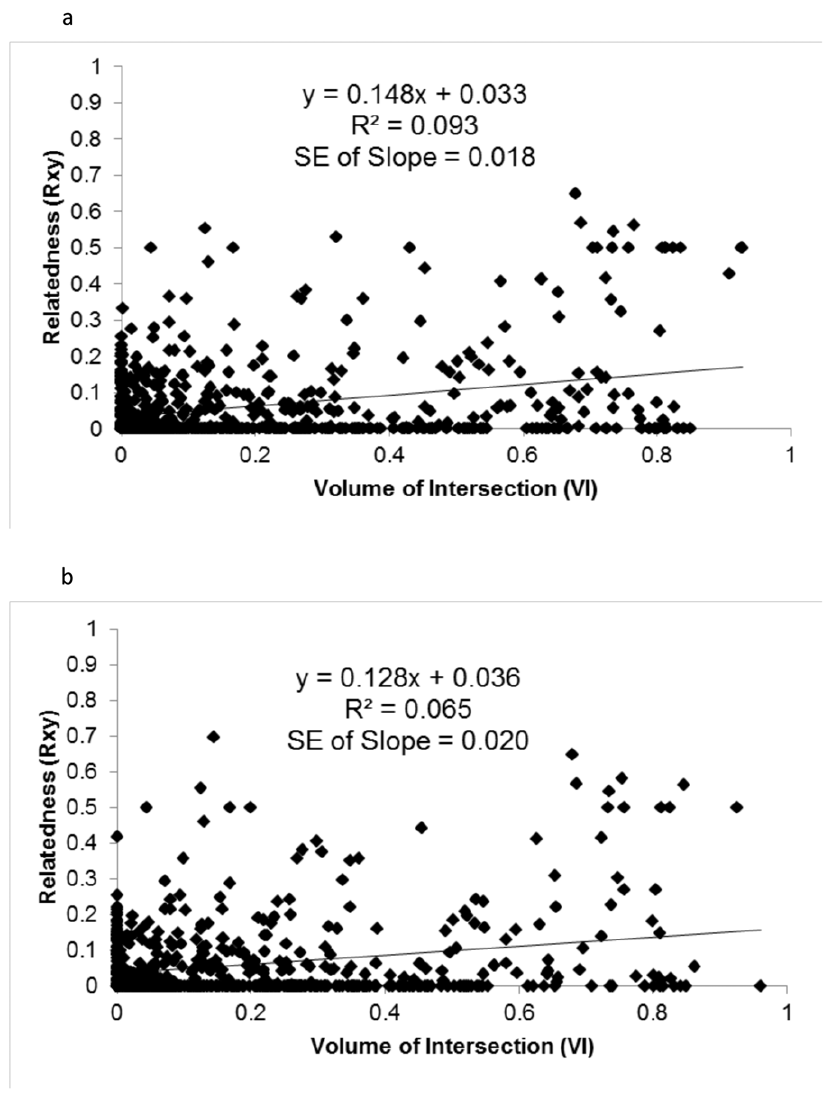
Figure 1. Scatterplots showing the relationship between degree of overlap and relatedness for white-tailed deer-pairs. Figure 1a is generated from the dataset where each pair contains at least one adult (dataset adult ), and figure 1b is generated from the dataset using only deer- pairs from capture groups 1 and 2 (dataset capgroup ). Figure 1a. Figure 1b.